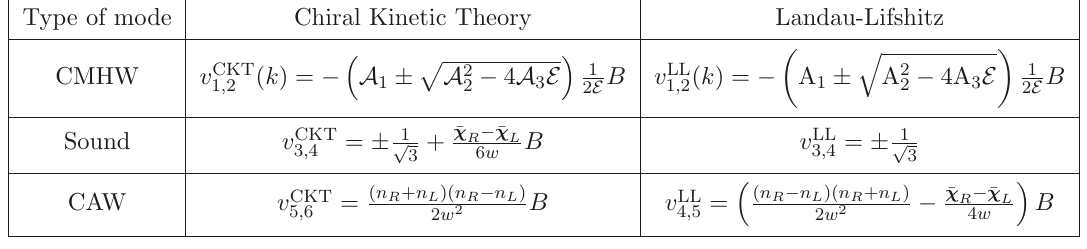
− ¯ χ + ¯ χ R , A 2 = L 8 w E A 1